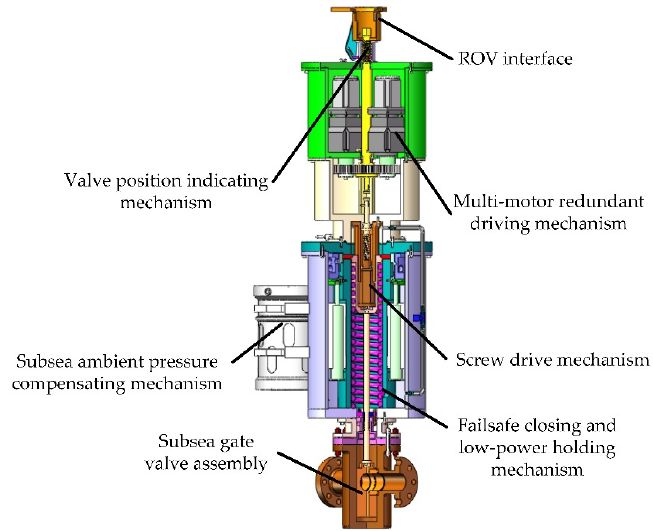
Figure 1. Schematic diagram of the all-electric subsea gate valve actuator.